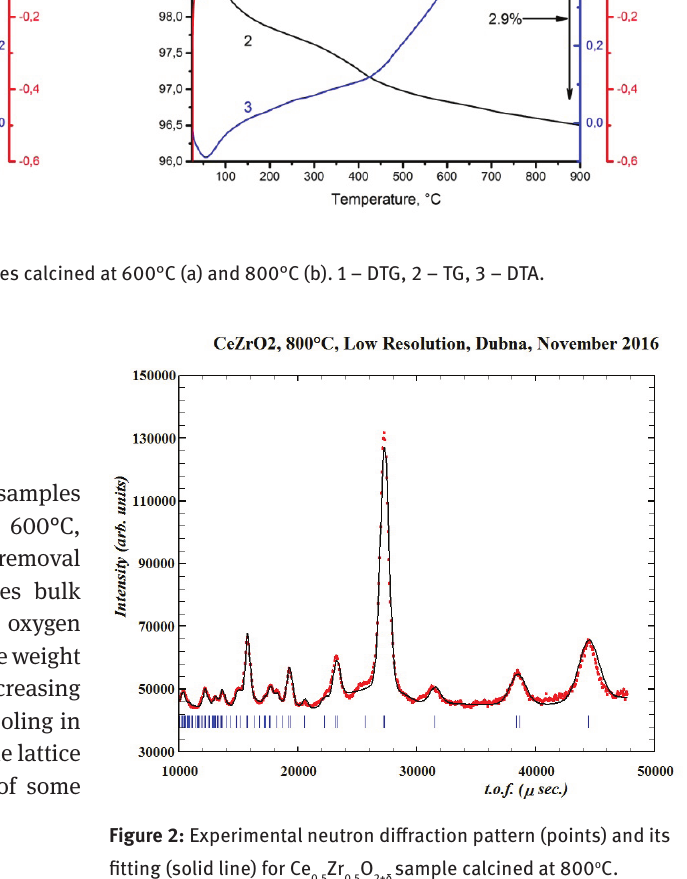
Zr O sample calcined at 800 o 0.5 0.5 2±δ